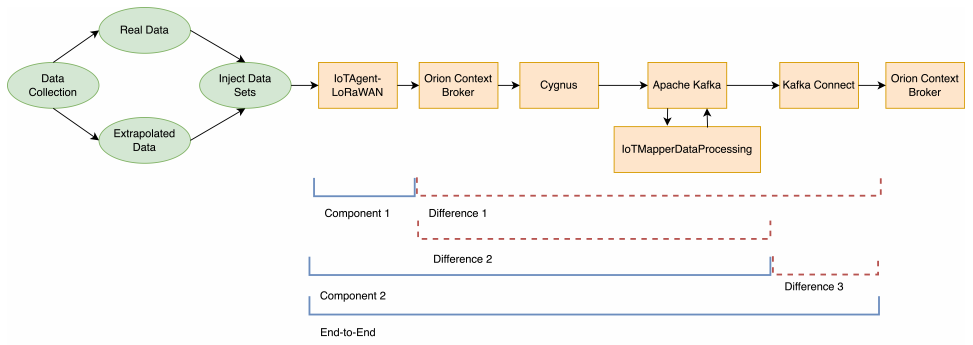
Figure 4. Graphical representation of the methodology framework, used during